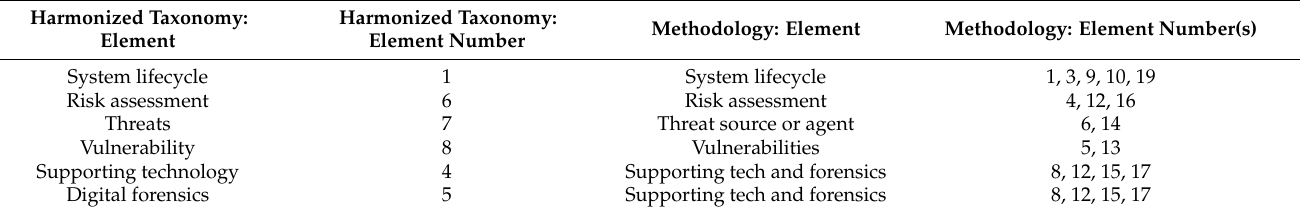
Table 3. The links between the taxonomy and the application methodology